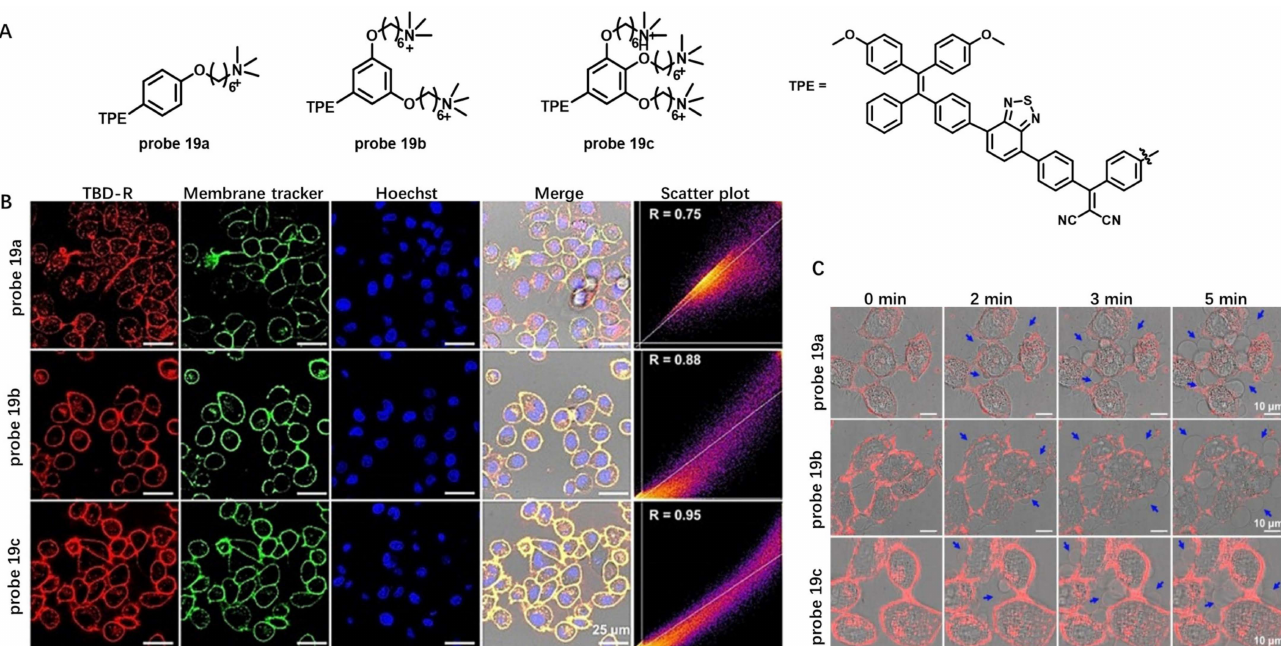
Figure 19. ( A ) Chemical structures of probe 19a – c . ( B ) CM staining using probe 19a – c . ( C ) Real-time observation of probe 19a – c treated HeLa under continuous confocal laser excitation. Scale bar: 10 µ m. Copyright 2021 John Wiley and Sons